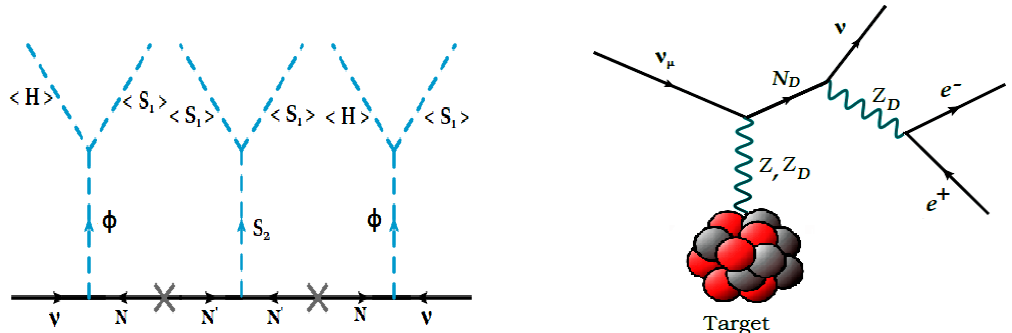
Figure 8.1: Left: diagram for the dynamically induced light neutrino masses in our model; Right: contributions to the cross section that in our model gives rise to MiniBooNE’s excess of electron-like events.